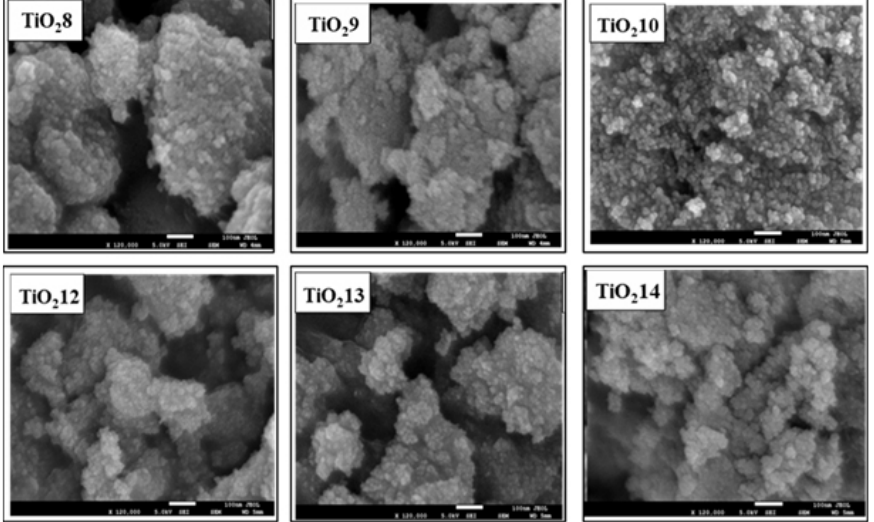
samples. All the images were taken at magnification of 120k with SEI detector Fig. 5. FESEM micrograph of the TiO 2 and the scale shown is 100